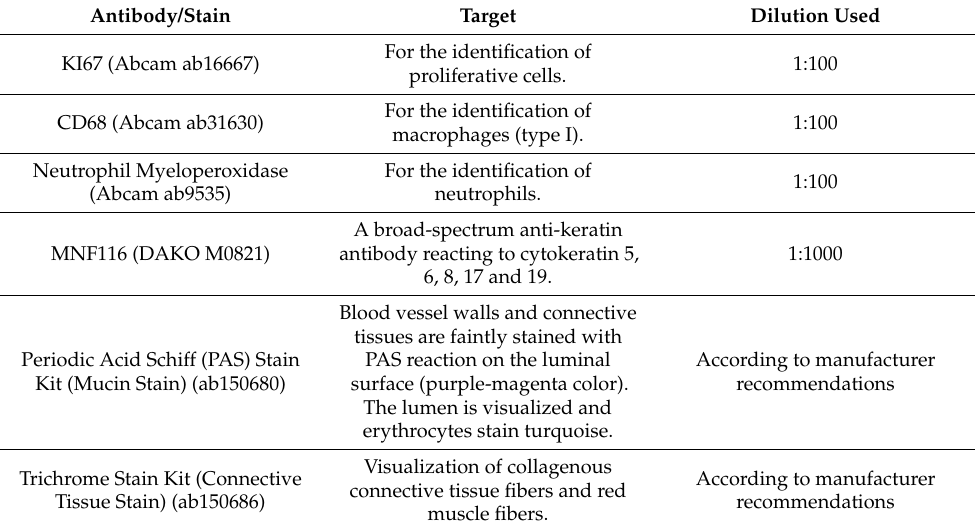
Table 2. Details of the antibodies and special staining methods used in this study.